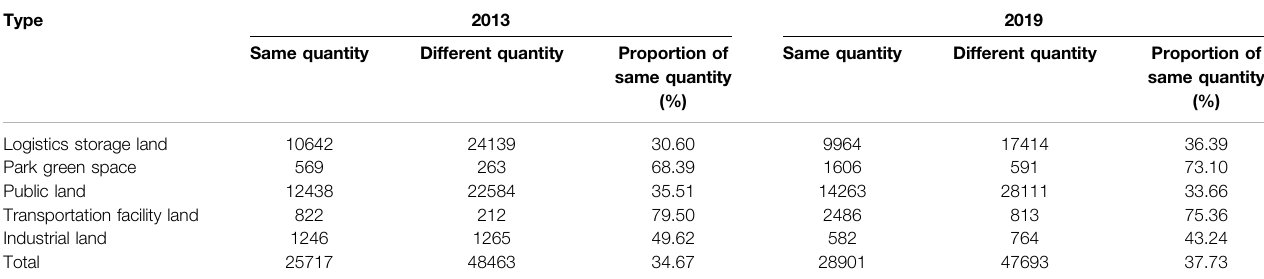
TABLE 5 | Comparison between POI data and interpreted land